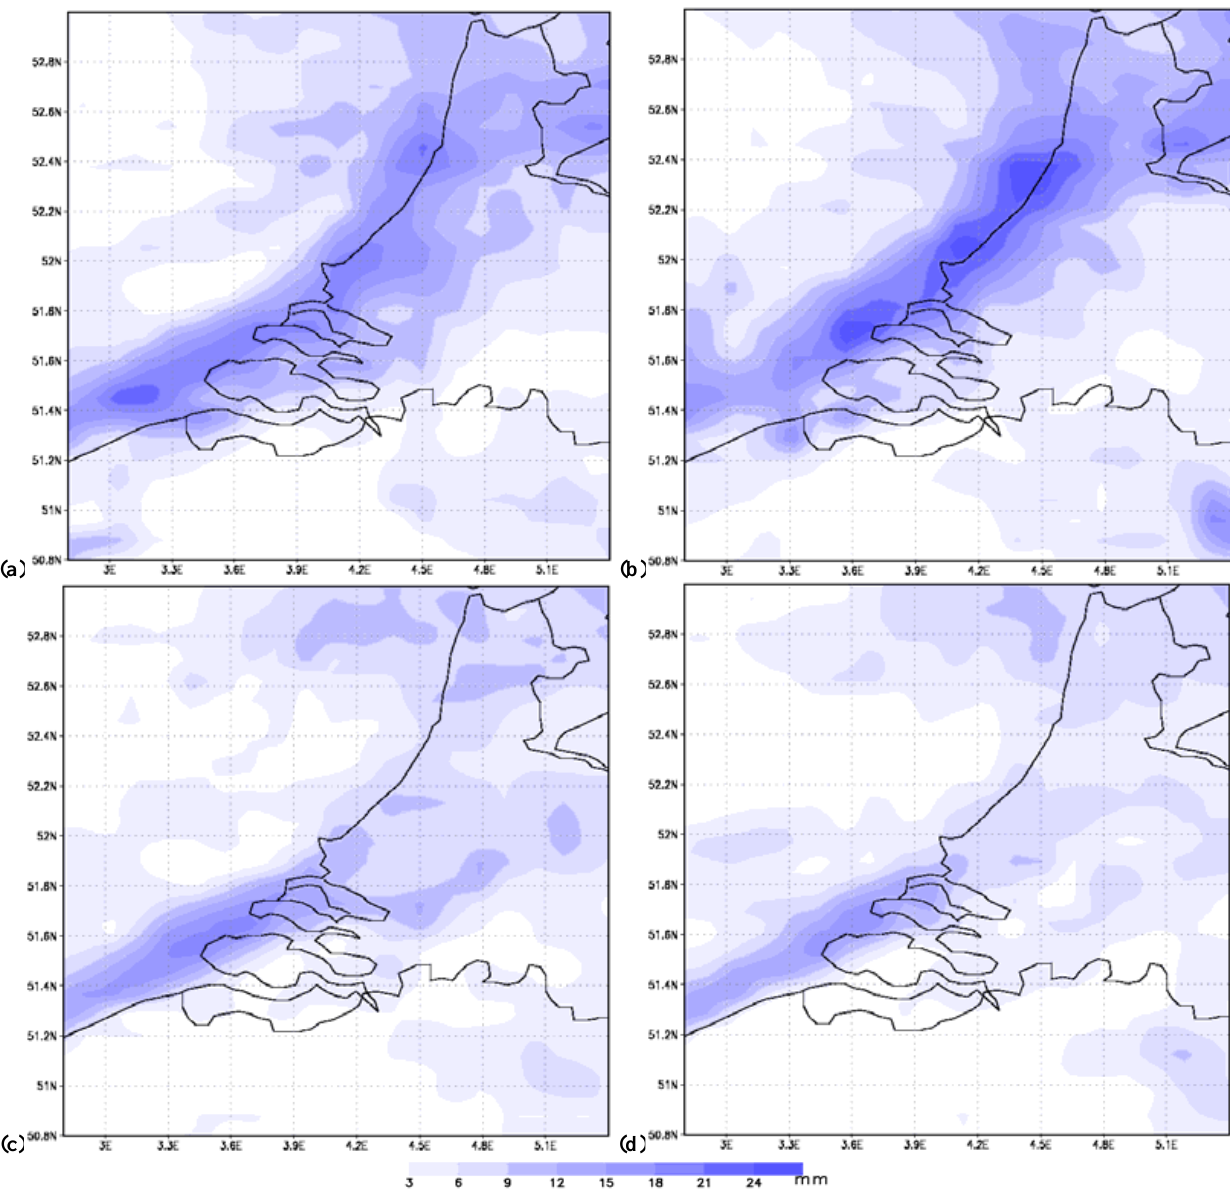
Fig. 10. Accumulated precipitation amounts (mm), produced by simulation 2 (a) , 3 (b) , 4 (c) and 5 (d) over the time period between 12 August 2004 12:00 UTC and 13 August 2004 12:00 UTC. Specifications of the simulations are written in Table